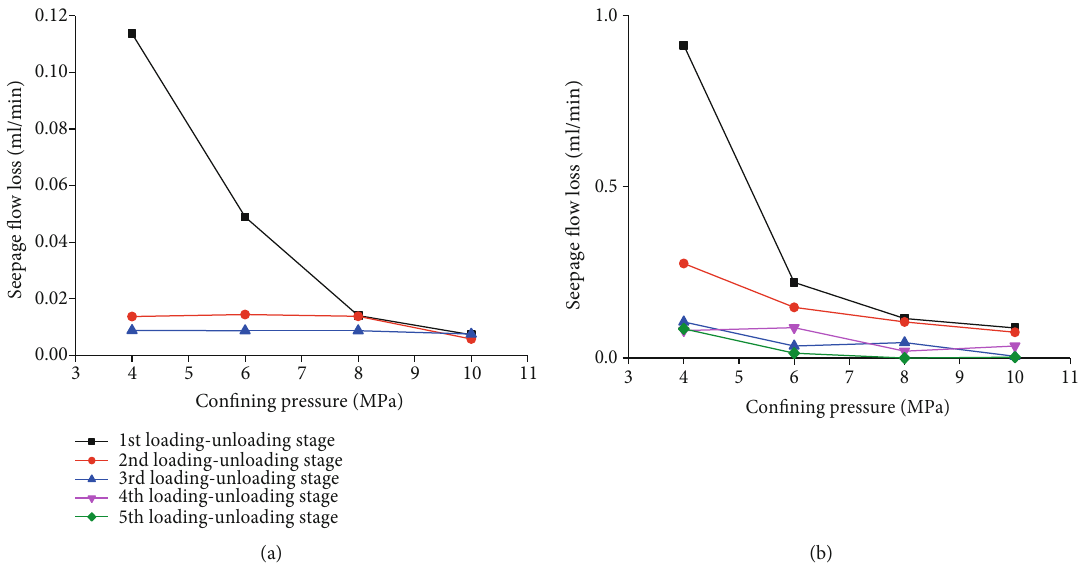
Figure 12: Curve of seepage fl ow loss with con fi ning stress for fractured (a) sandstone and (b) granite specimens.